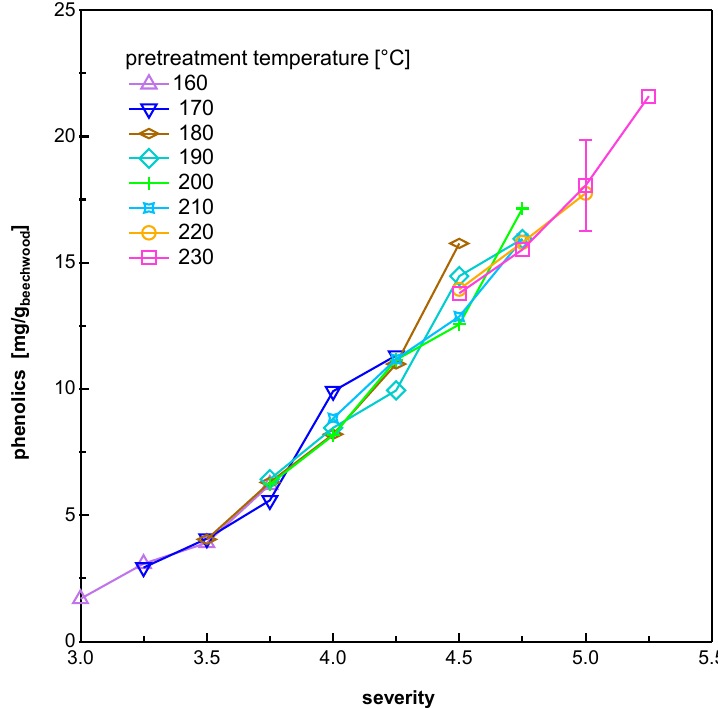
Figure 3. Formation of phenolics during steam explosion pretreatment. The amount of phenolics that is released into the prehydrolyzate during steam explosion pretreatment is shown as a function of the pretreatment severity and temperature.